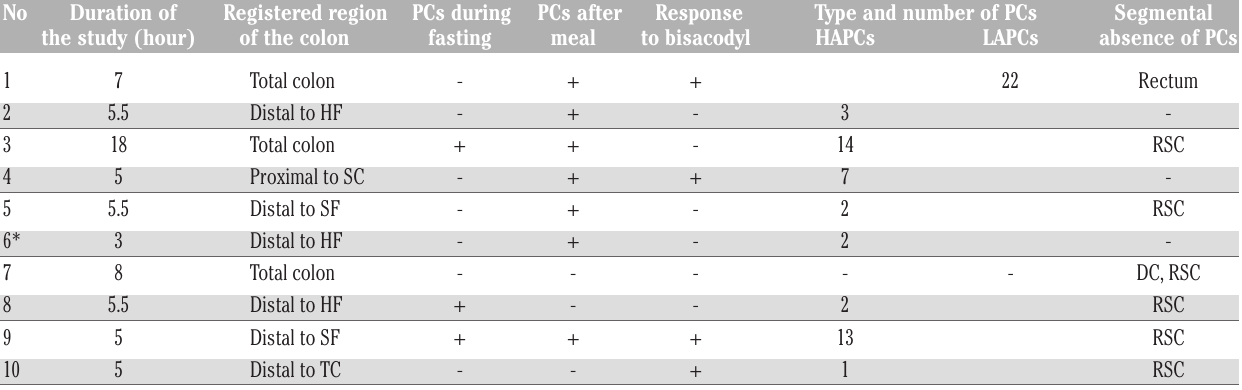
Table 4. Colonic manometry findings of the patients in group #2. No Duration of Registered region PCs during PCs after